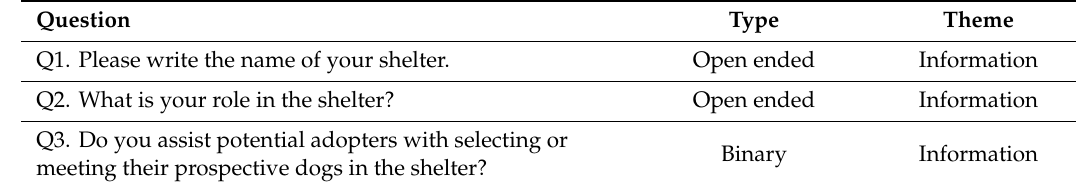
Table 4. Questions asked during the focus